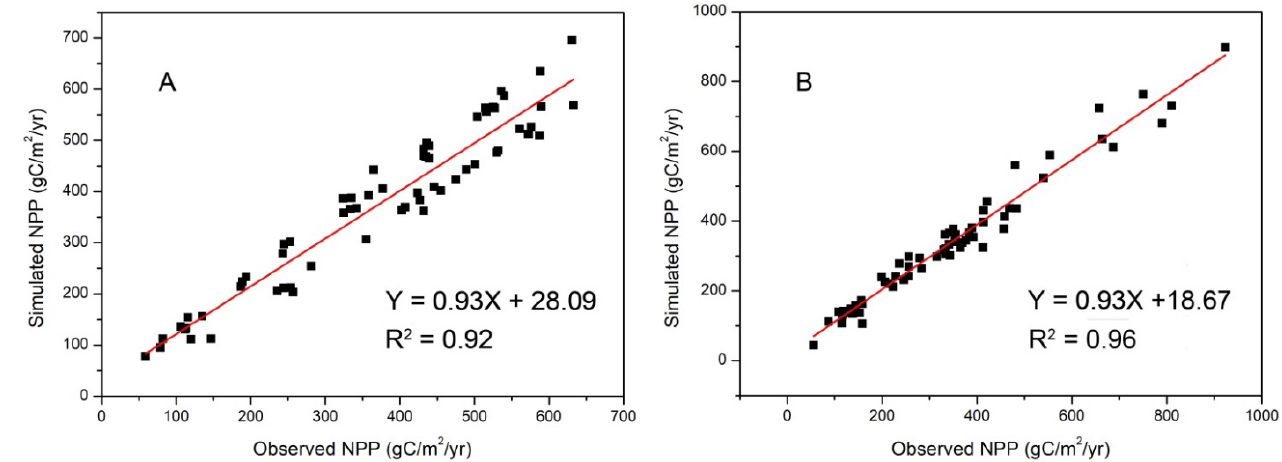
Figure 2. Comparisons of the annual NPP between the simulated and observed data under grazed ( A ) and non-grazed ( B ) conditions in Qinghai grasslands (NPP—net primary productivity). ( A ) and non-grazed ( B ) conditions in Qinghai grasslands (NPP—net primary